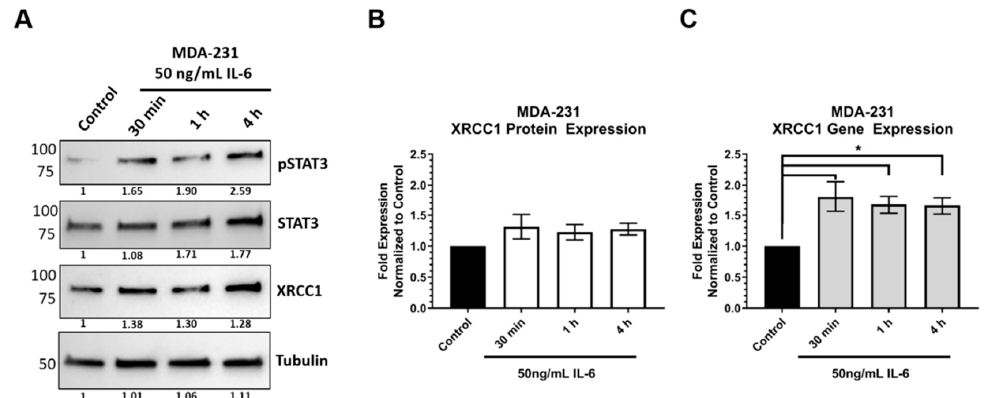
Figure 7. IL-6 increases phospho-STAT3 and increases the expression of XRCC1 in MDA-231. ( A ) Representative immunoblot of phospho-STAT3 (Y705), STAT3 and XRCC1 protein expression after 30 min, 1 and 4 h of exposure to 50 ng/mL IL-6. α -tubulin is used as a loading control. ( B ) Quantification of protein expression changes in XRCC1 resulting from 50 ng/mL IL-6 exposure. ( C ) Quantification of XRCC1 mRNA expression following 50 ng/mL IL-6 exposure. * p < 0.05.